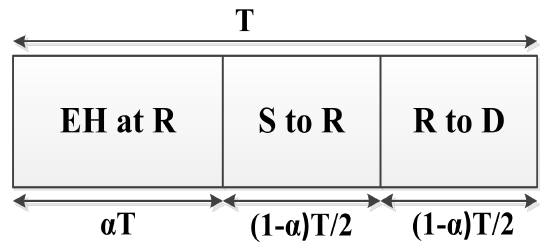
Fig. 2: The energy harvesting and information process- ing by the time switching protocol.